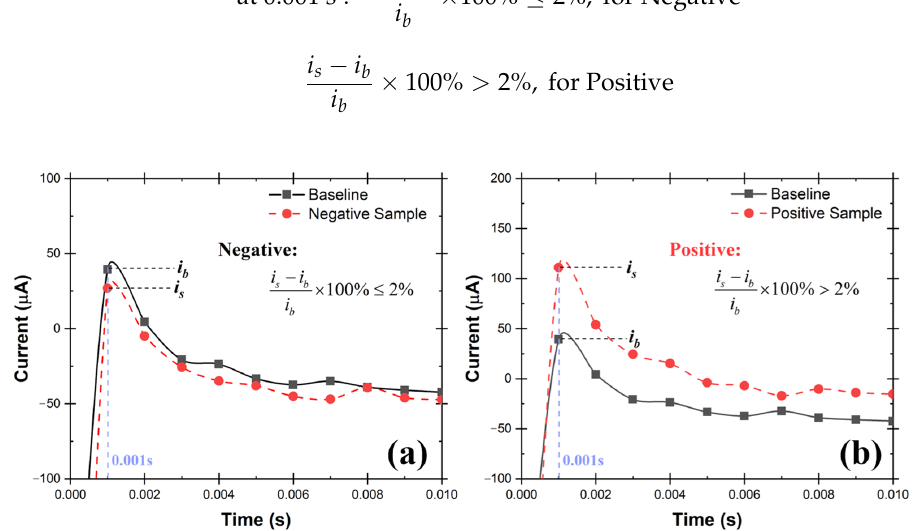
Figure 8. Example chronoamperometry graph of ( a ) Negative testing solution, ( b ) Positive testing solution. If the current at 0.001 s of testing solution is 2% higher than the baseline solution, the sample is Positive, otherwise, it is Negative.